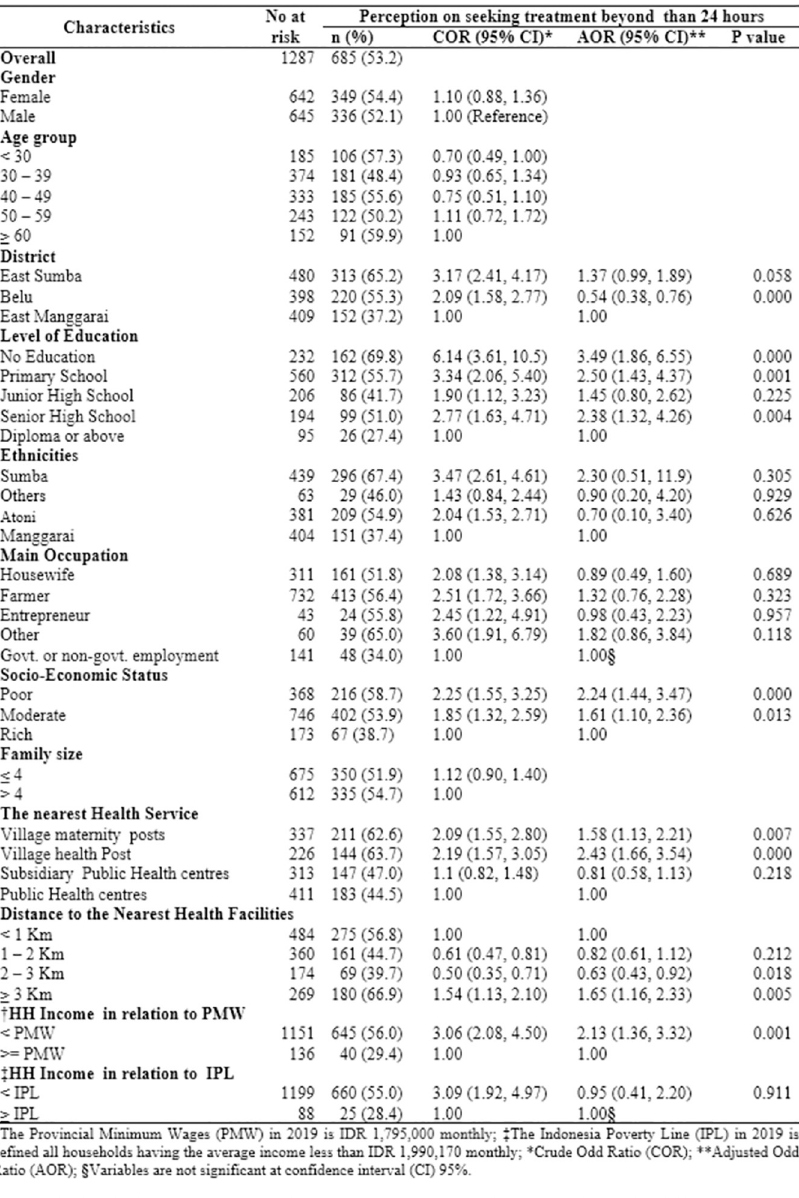
Fig 2. The level of perception on seeking malaria treatments beyond 24 hours by different sociodemographic and environmental characteristics in the East Nusa Tenggara Province, Indonesia (n = 685).